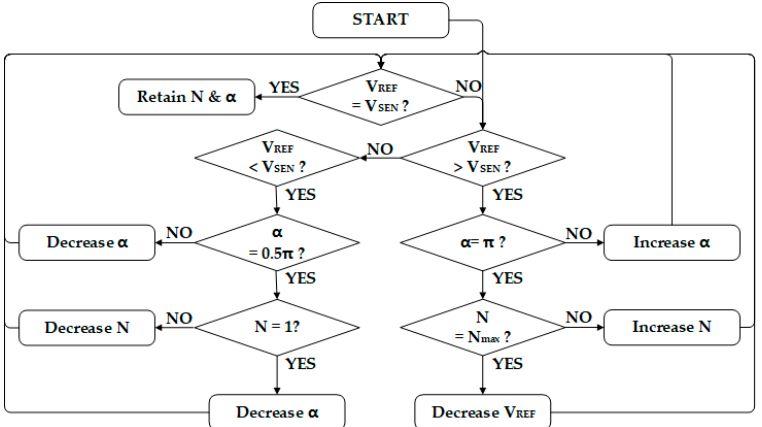
Figure 4. Flow chart of the proposed control method.